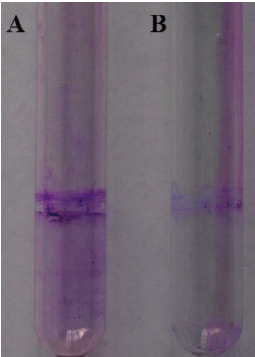
Figure 5. Effect on the biofilm formation. A : Untreated blank control; B : Xoo + Compound 2-(methylsulfonyl)-5-(4-fluorophenyl)-1,3,4-oxadiazole.